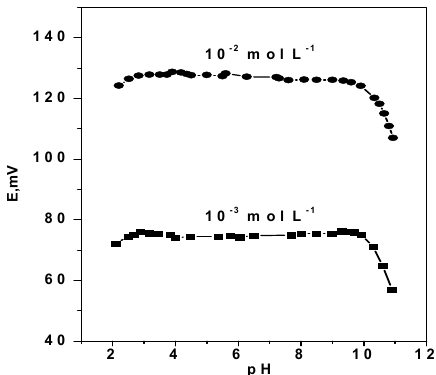
Figure 6. pH e ff ect on the potentiometric response of DMA sensors. Figure 6. pH effect on the potentiometric response of DMA sensors.